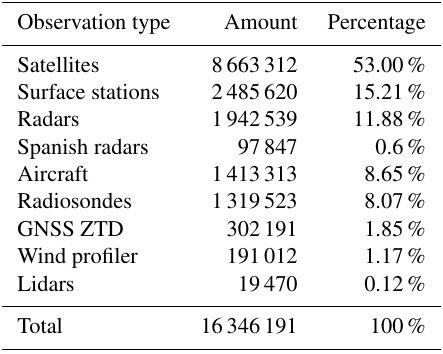
Table 1. Sorted amounts of assimilated data in REANA over the SOP1 period (5 September–5 November